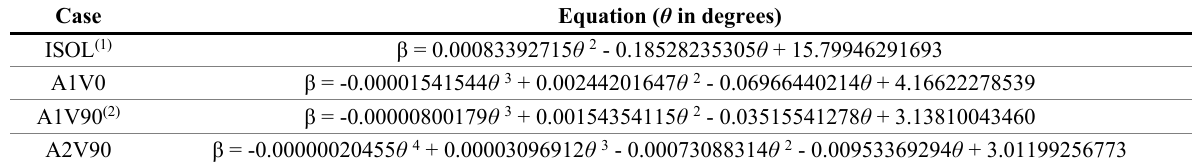
Table 10. Equations of β for displacement at the top, y-direction – H/1370 limit criterion.